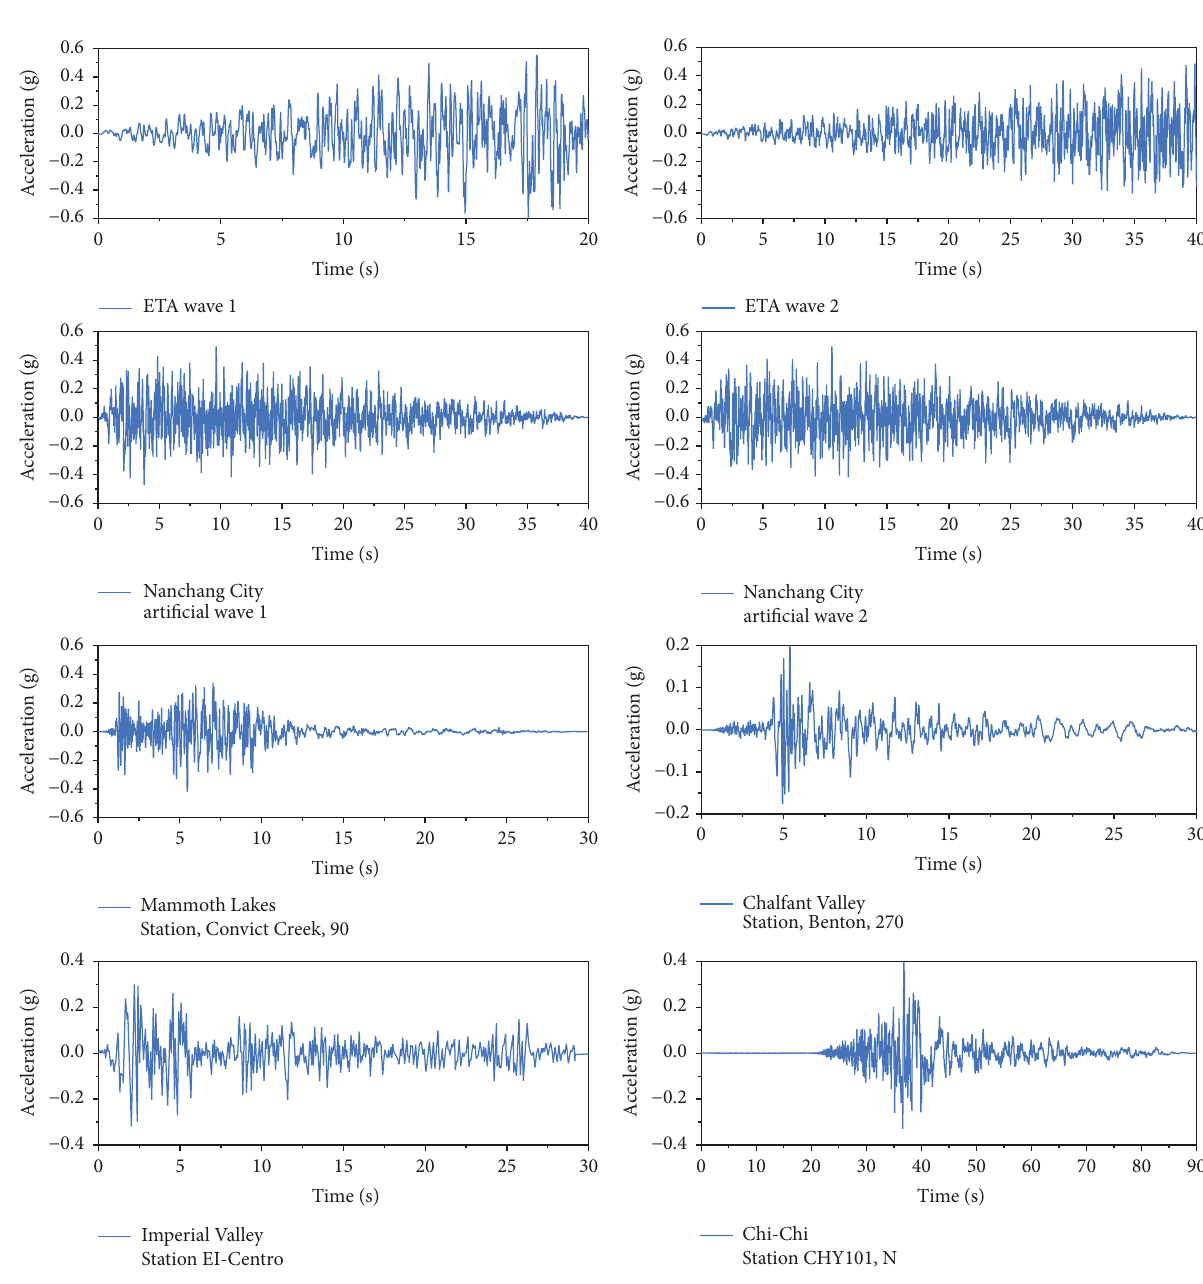
Figure 4: A suite of 8 ground motions for longitudinal